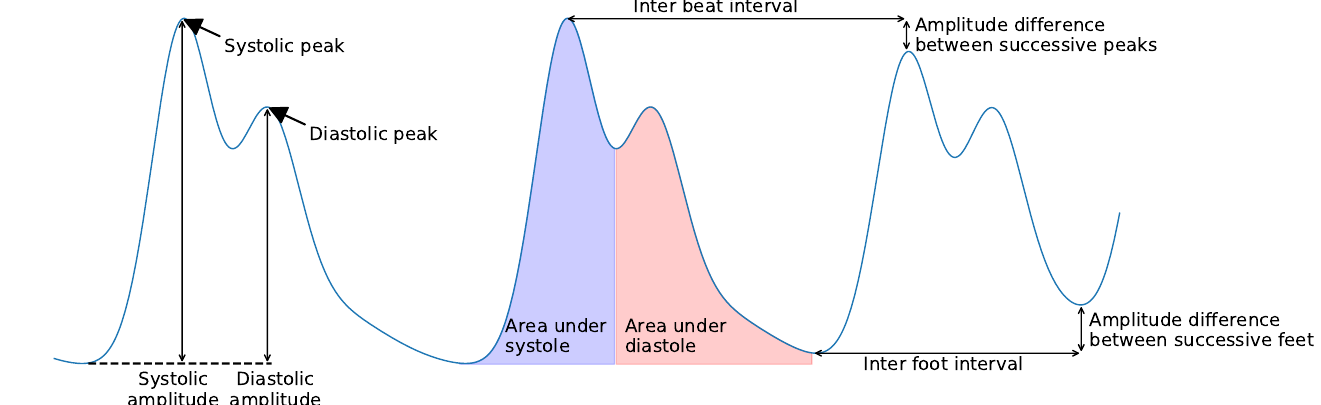
Figure 6. Figure illustrating cPPG pulses and possible features extracted from